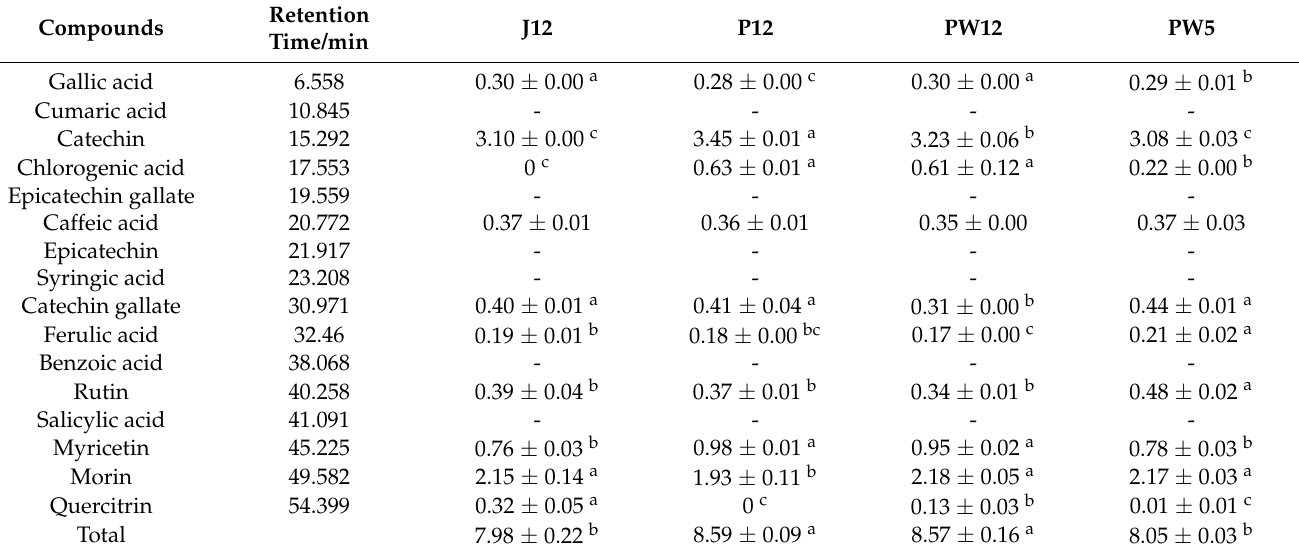
Table 2. Monomer phenol contents of the investigated wines